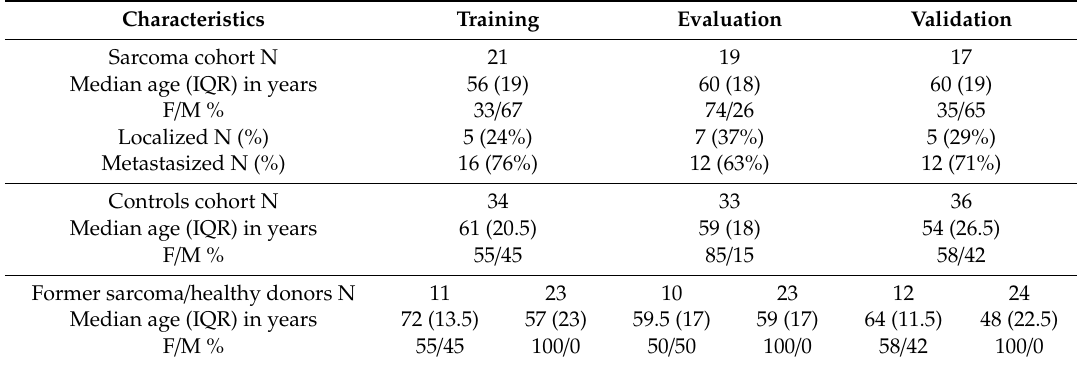
Table 1. Demographic characteristics. The demographic characteristics of the sarcoma and controls (former sarcoma patients and healthy donors) are shown, and their distribution between the training, evaluation, and validation series.